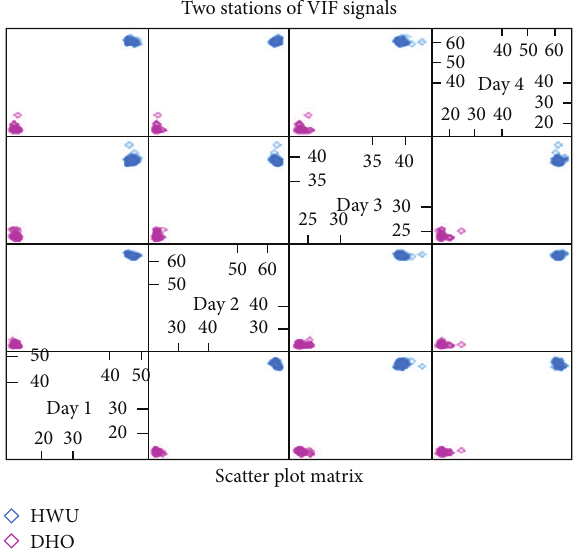
Figure 3: Scatter plot of VLF signals for the two stations.